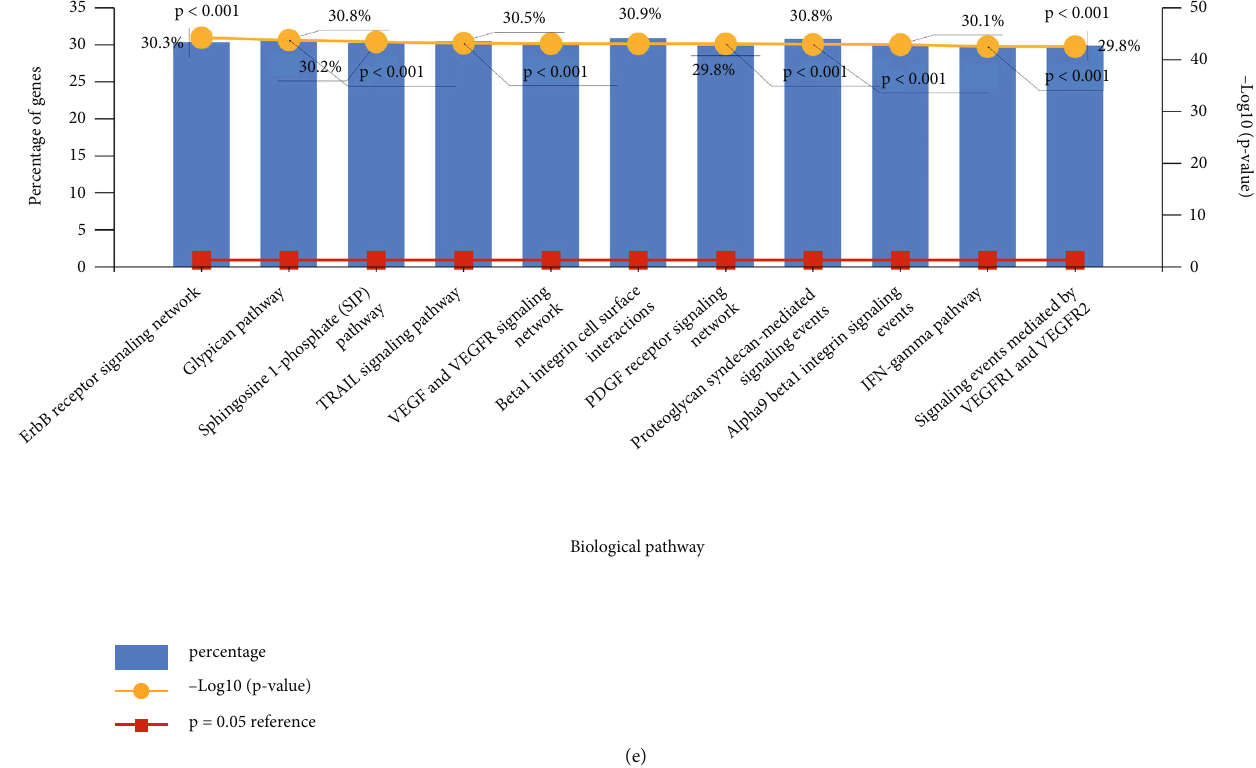
Figure 4: Gene – miRNA – lncRNA interaction network analysis. (a) Results of miRNA prediction of core-DEGs; (b) results of CC enrichment analysis of 283 miRNAs by Funrich; (c) results of BF enrichment analysis of 283 miRNAs by Funrich; (d) results of MF enrichment analysis of 283 miRNAs by Funrich; (e) results of biological pathways enrichment analysis of 283 miRNAs by